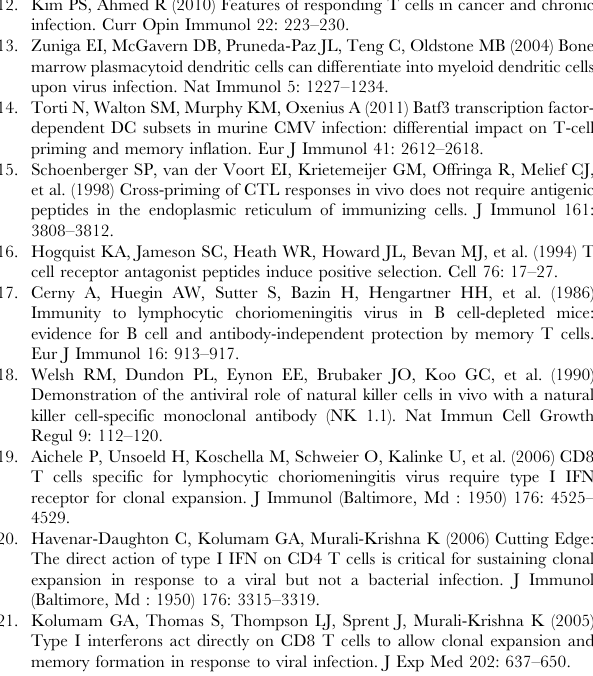
Figure S4 Intact intrinsic function of homozygous Slc15a4 feeble/feeble NK cells. Percentage of CFSE-labeled Tap1 2 / 2 cells remaining in the blood of Tap1 2 / 2 , C57BL/6J, and feeble mice 24 h after injection of a 1:1 mixture of CFSE- labeled Tap1 2 / 2 and WT splenocytes was measured by flow cytometry. 1 of 2 independent experiments is shown with the same results. There was no statistical difference between WT and feeble . (TIF) Figure S5 Immune cell recruitment and activation early during splenic infection. Splenocytes were harvested from WT and feeble mice 0, 1, 3 and 5 days post infection (A–D, respectively) with LCMV Clone 13. Cells were counted and stained with antibodies to surface markers to distinguish B cell, T cell, dendritic cell (DC) and macrophage cell numbers. Cells were also stained with antibodies to MHC Class I, Class II, CD80 and CD86 to assess the activation status of B cells, macrophages and DCs. Individual replicates, mean and standard error of the mean (where indicated for total viable cells) are shown. n= 5 per group of infected mice. 1 of 2 similar experiments is shown. Unless marked, p . 0.05 between WT and feeble and not statistically significantly